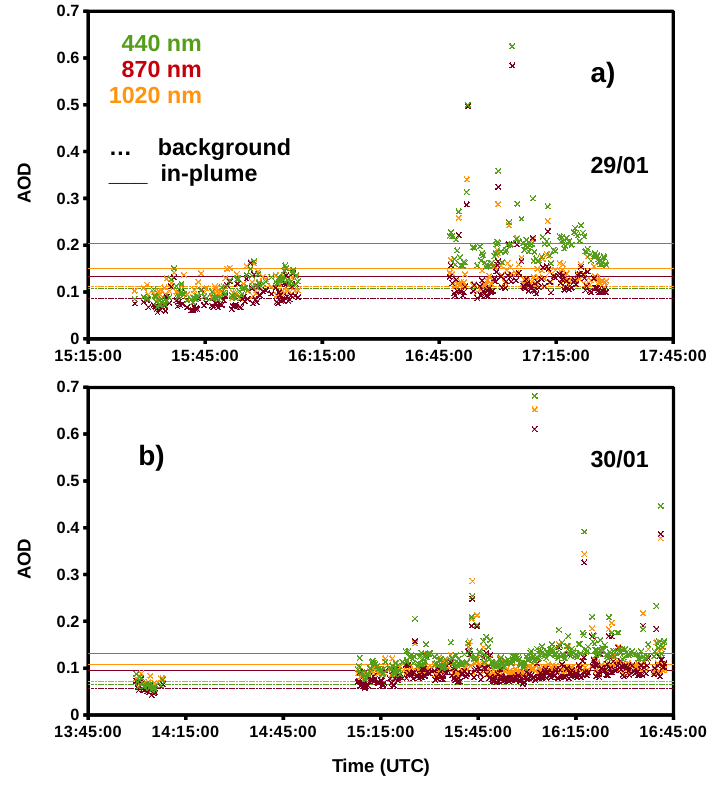
Figure 2. MIISP AOD observations at 440, 870 and 1020 nm on 29 ( a ) and 30 January 2011 ( b ) at Pacaya volcano. Average background (dotted lines) and in-plume AODs (solid lines) are also shown. Background and in-plume measurements are taken during the time intervals of Table 1 (see text for details). All times are